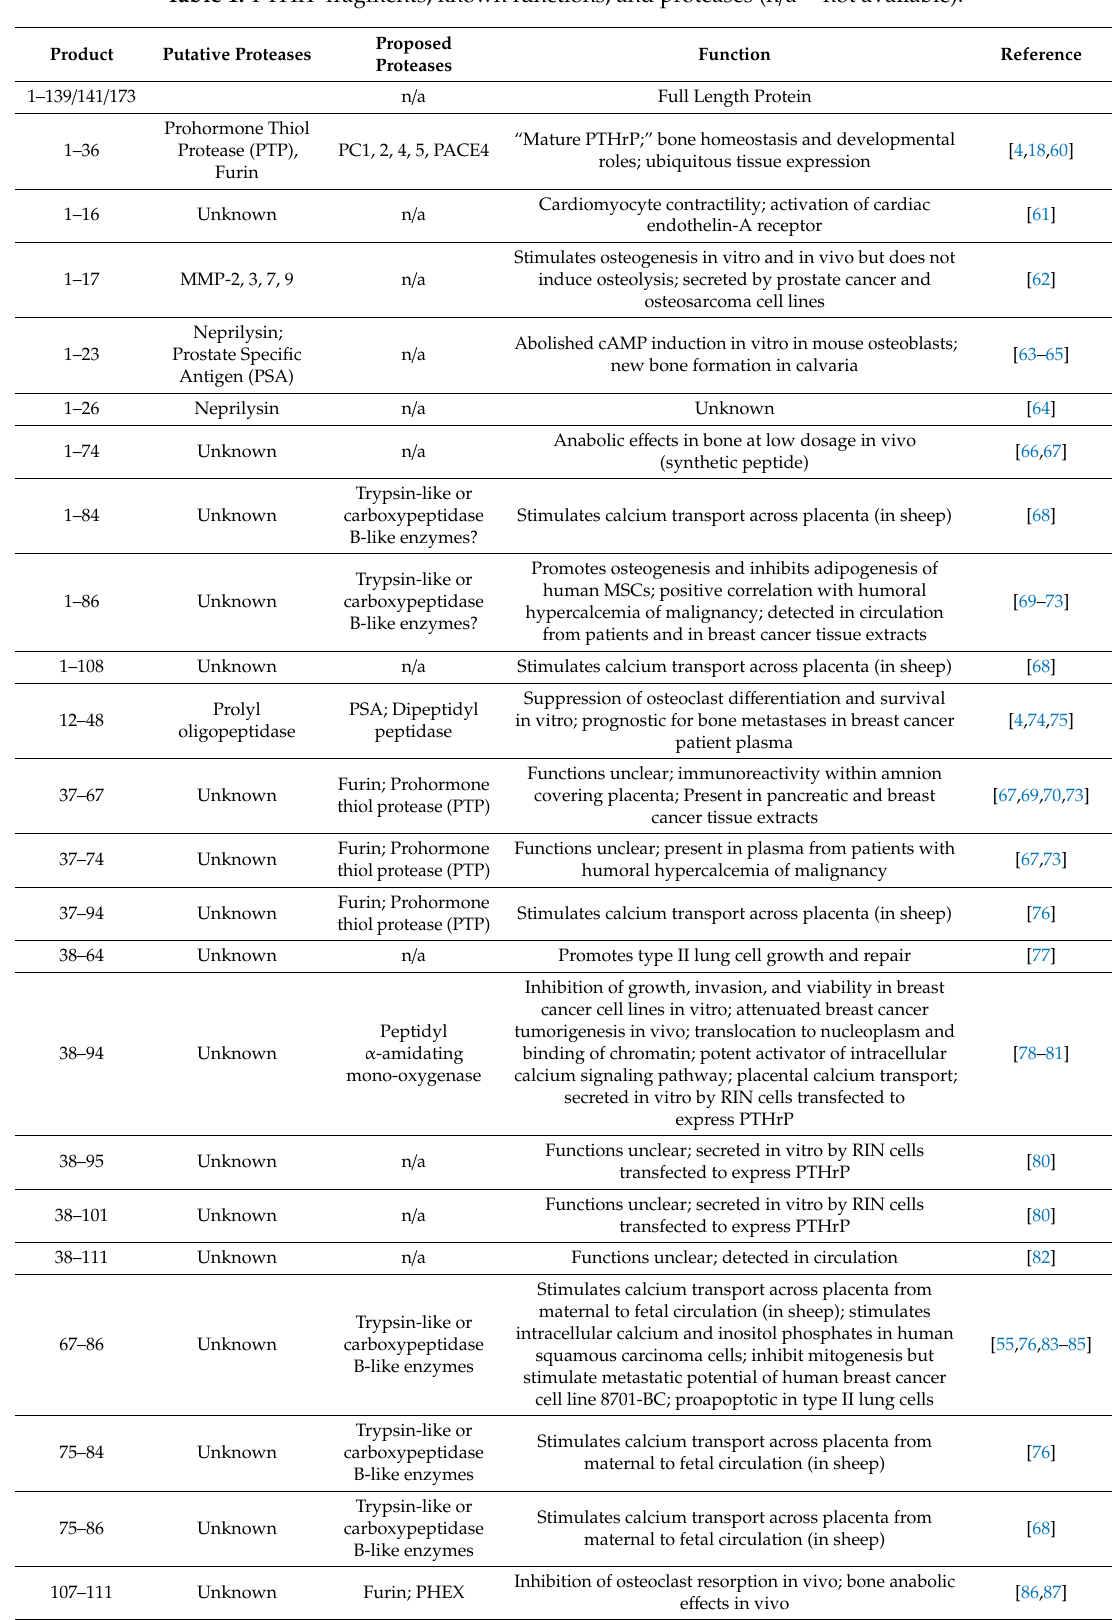
Table 1. PTHrP fragments, known functions, and proteases (n / a = not